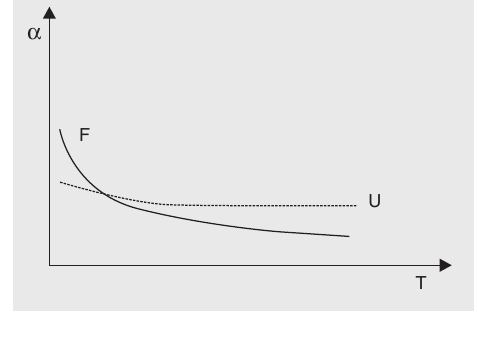
Figure 3. Hypothetical tempera- ture dependence of the volumes of the folded (F) and unfolded (U) states based on the hypo- thetical temperature (T) depend- ence of α in Figure 2. ( ∆ Vu is given by the arrows at several